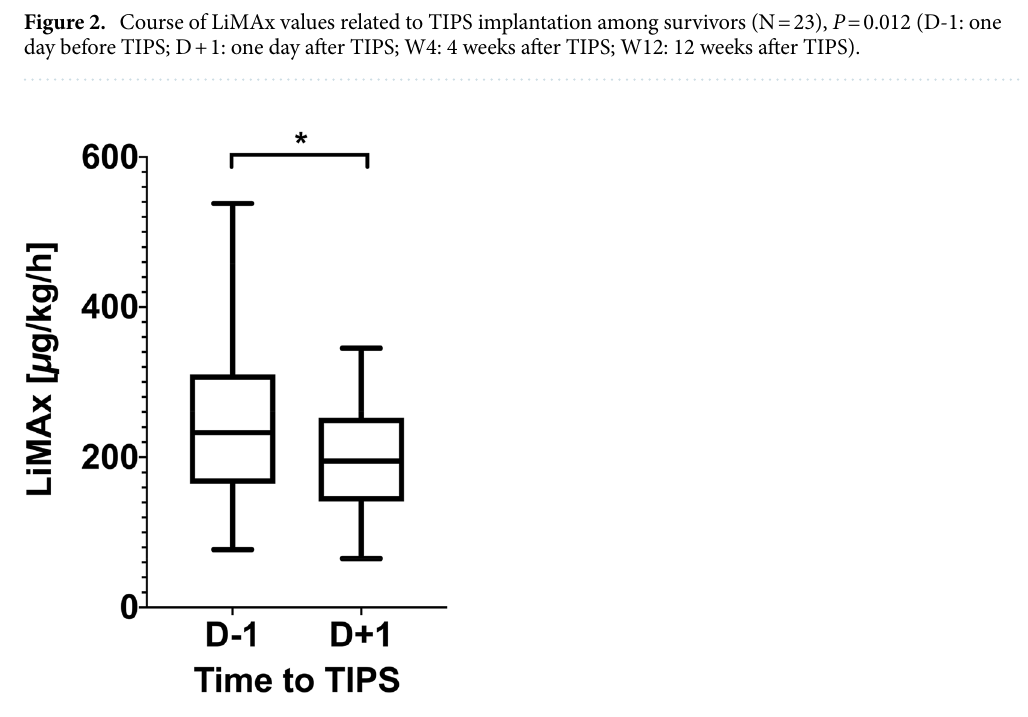
Figure 3. TIPS implantation leads to significant decrease of LiMAx values (N = 30, P = 0.03). (D − 1: one day before TIPS; D + 1: one day after